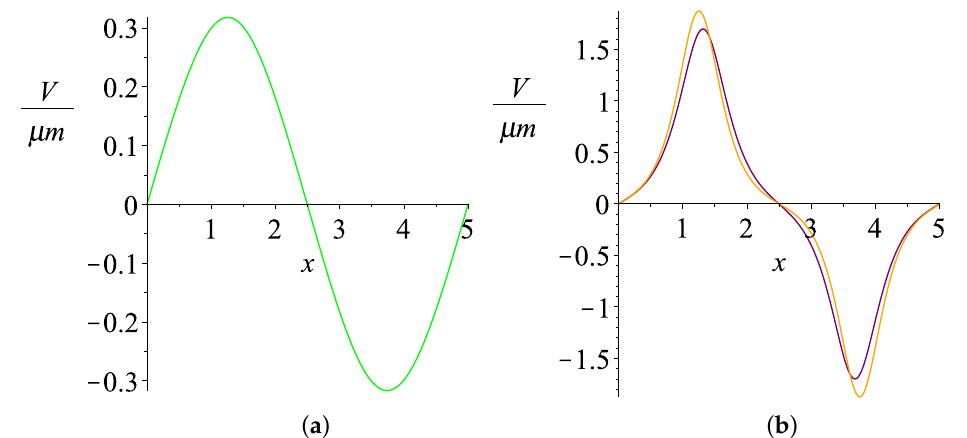
β Figure 8. Subfigure ( a ): the eigenmode of problem α (green curve) corresponding to the propagation P constant denoted by the green diamond in Figure 7. Subfigure ( b ): the eigenmode of problem (purple curve) and (orange curve) corresponding to the propagation constant denoted by the P α purple and orange diamonds in Figure 7.